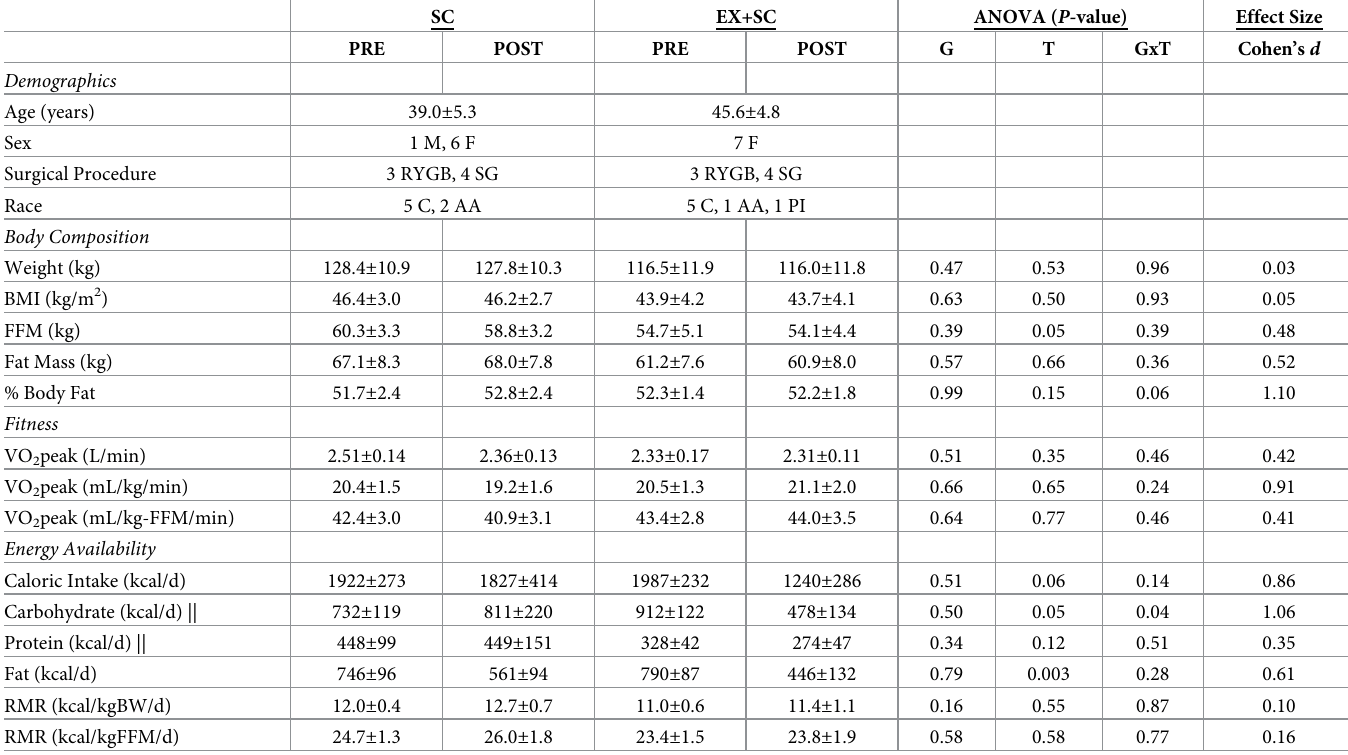
Table 1. Effect of SC and EX+SC on subject